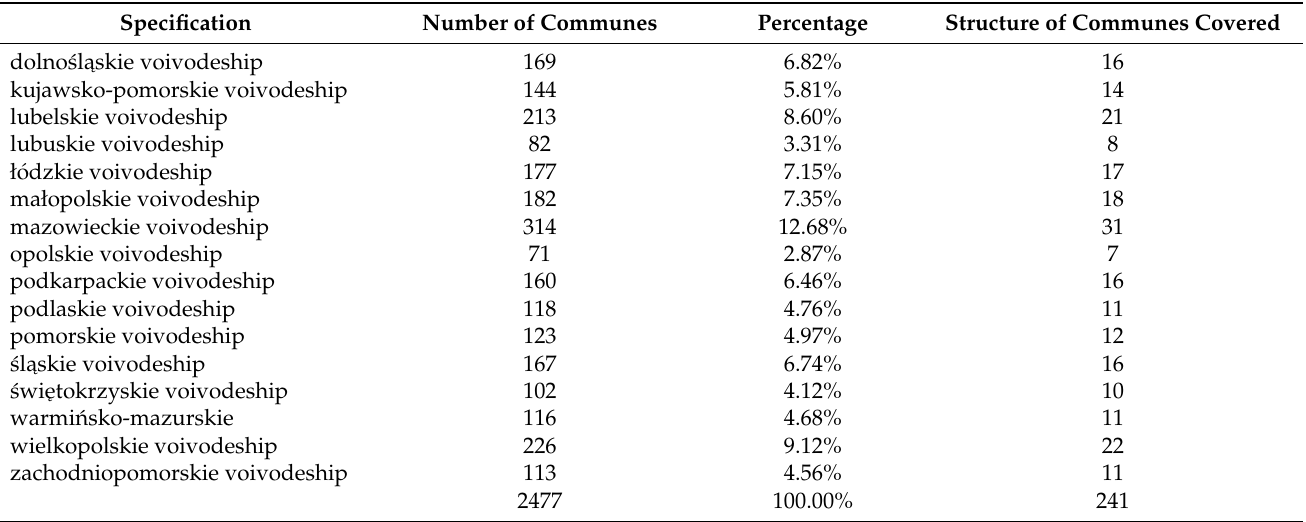
Table 1. Number of communes per voivodeship in Poland.